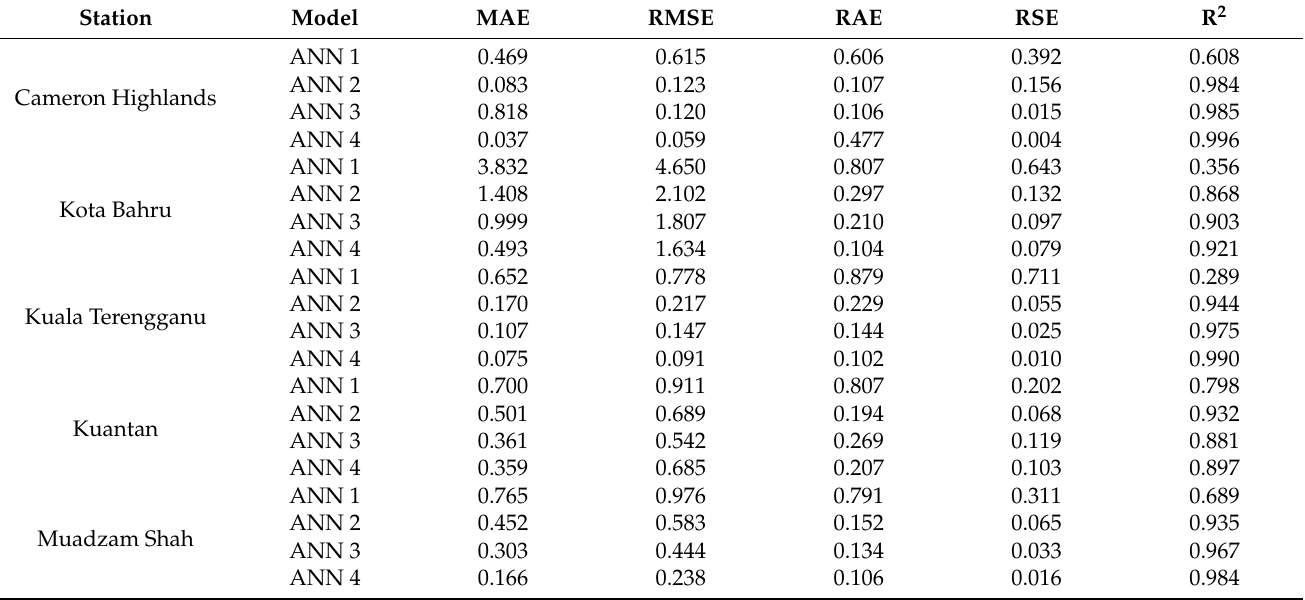
Table 5. Statistical evaluation of ANN model with different meteorological variables for testing